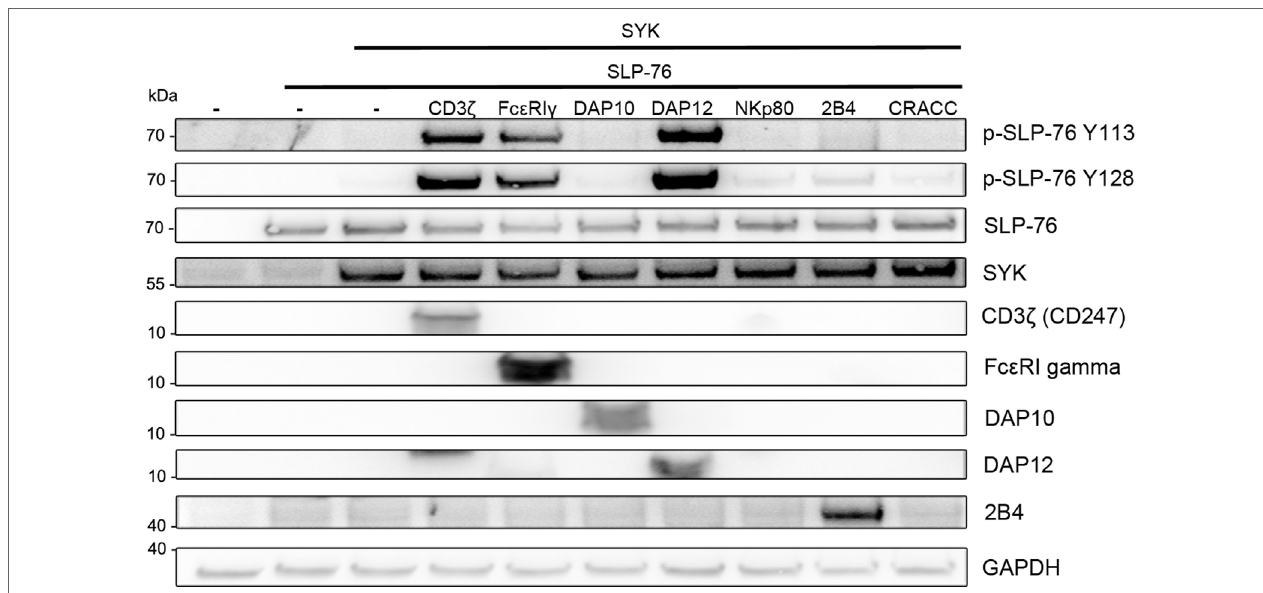
FigUre 2 | SLP-76 phosphorylation in the presence of SYK and ITAM-containing receptors. S2-cells were co-transfected with the indicated proteins and GFP as a transfection marker. Equal numbers of FACS-enriched GFP + S2-cells were lysed and analyzed by western blot for SLP-76 phosphorylation and the expression of the transfected proteins. Expression of NKp80 and CRACC was verified by FACS analysis (not shown). Results are representative of at least five independent